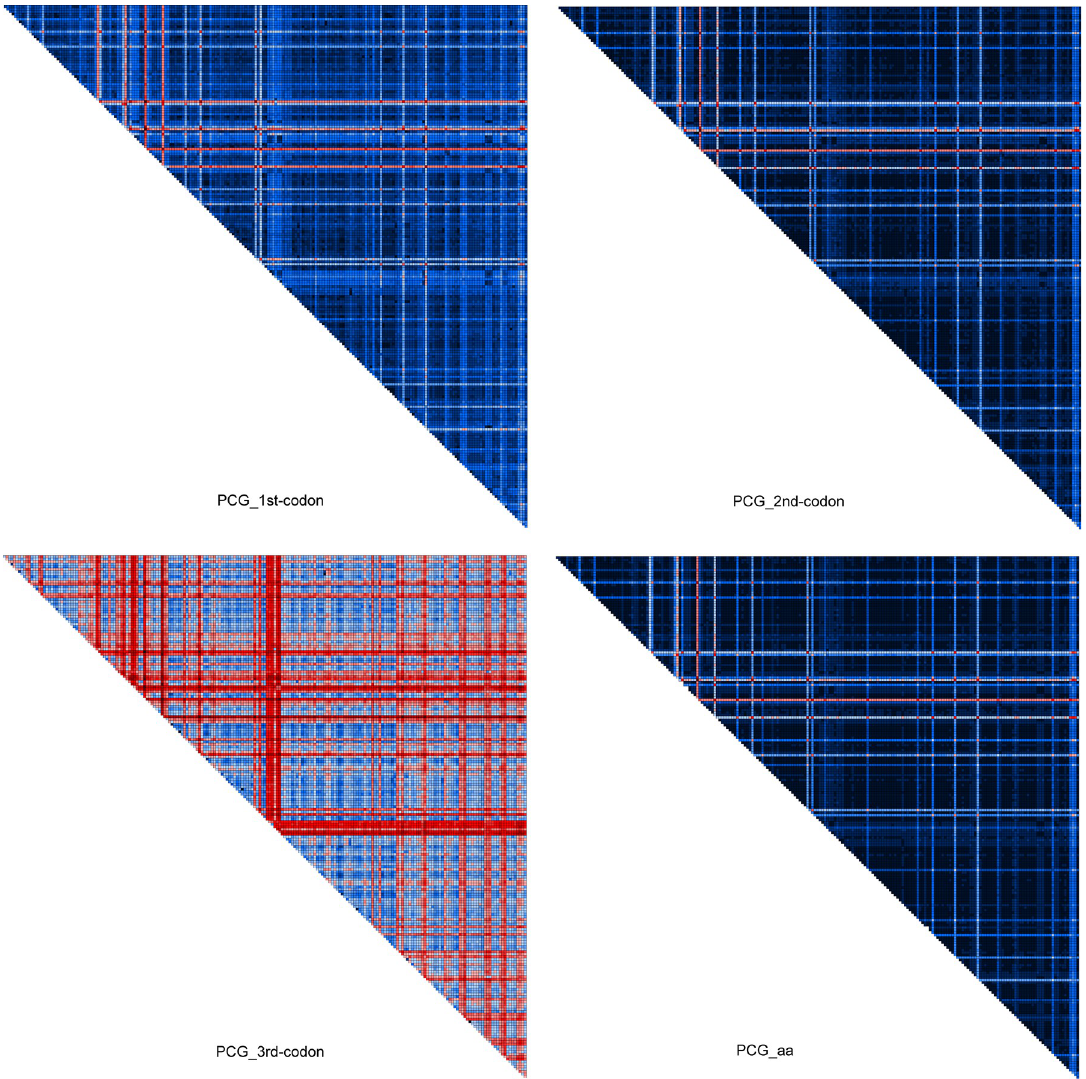
Fig 7. AliGROOVE heat maps of pairwise sequence comparisons for the data partitions PCG_1st-codon, PCG_2nd-codon, PCG_3rd-codon and the dataset PCG_aa. The AliGROOVE graph shows the mean similarity scores between sequences. AliGROOVE scores range from − 1 (indicating great difference in rates from the remainder of the data set, i.e. red coloring implies the significant heterogeneity) to +1 (indicating rates match all other